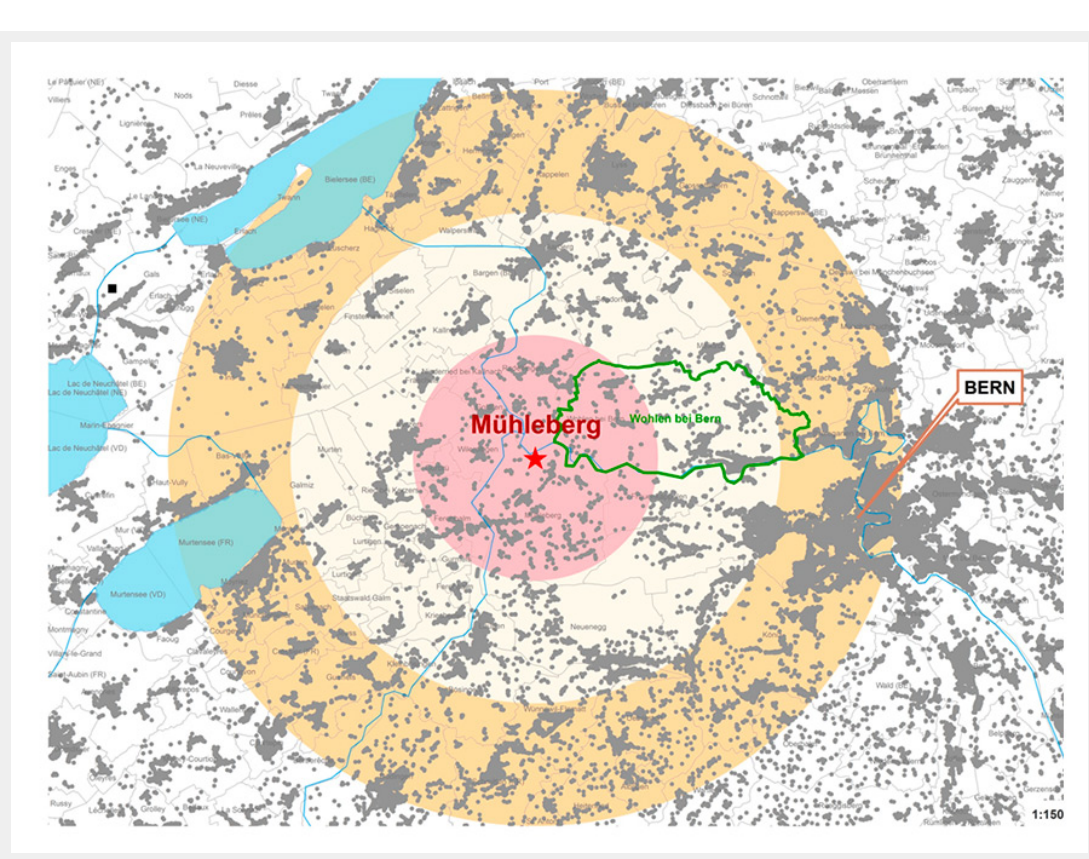
Map showing consecutive 5-km zones (<5 km, 5–10 km, 10–15 km) around the Mühleberg nuclear power plant, residential homes of children from the general population (grey points), community boundaries (grey faint lines, community “Wohlen bei Bern” with green boundaries as an illustrative